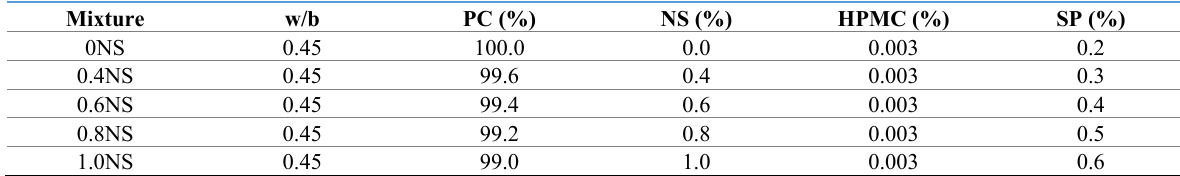
Table 2. Sample composition of the cement pastes per 100 g of